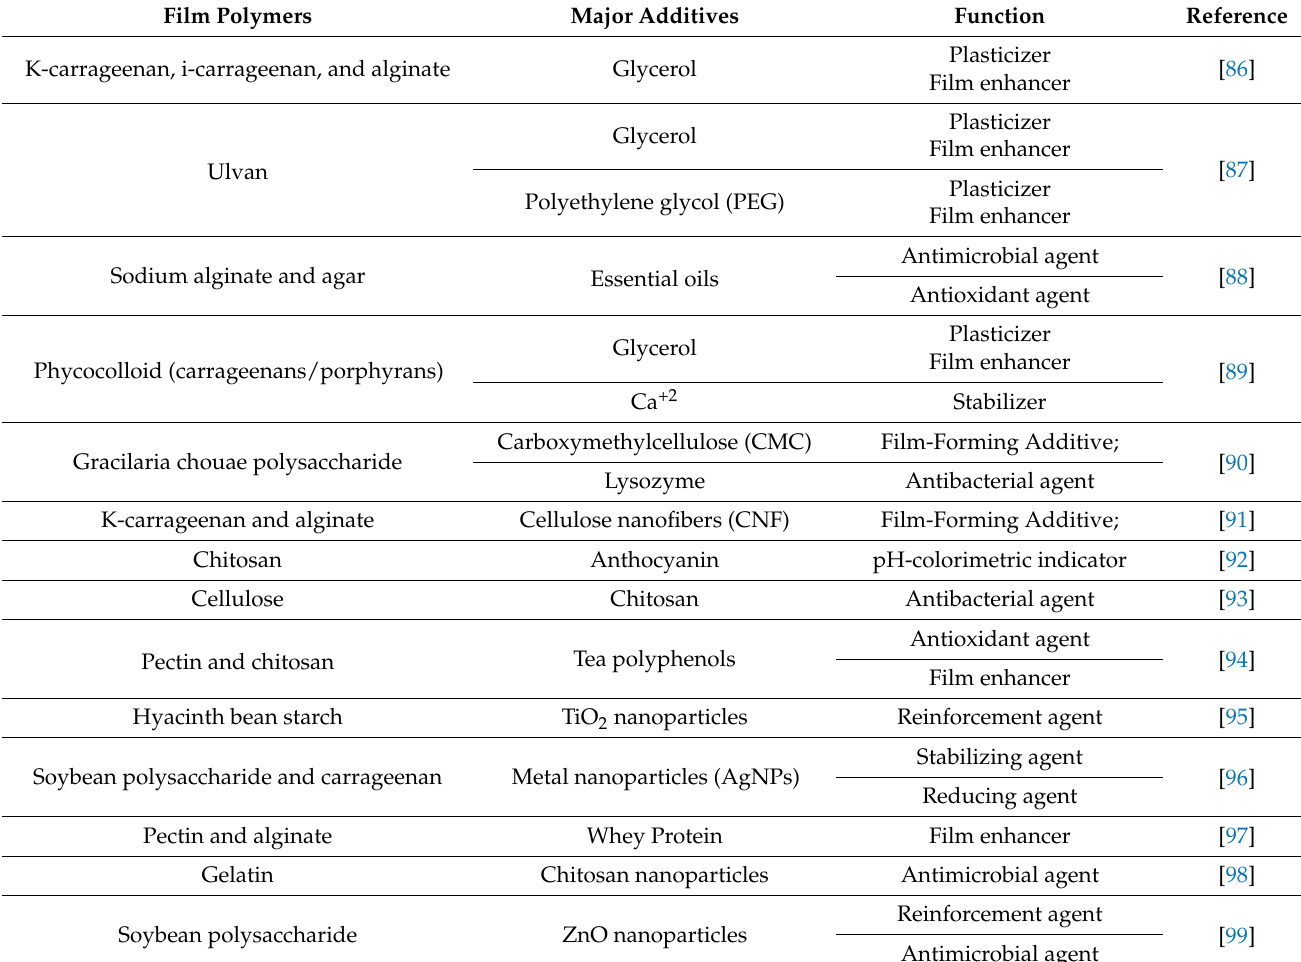
Table 1. Role of common additives added to some polysaccharide-based edible films and